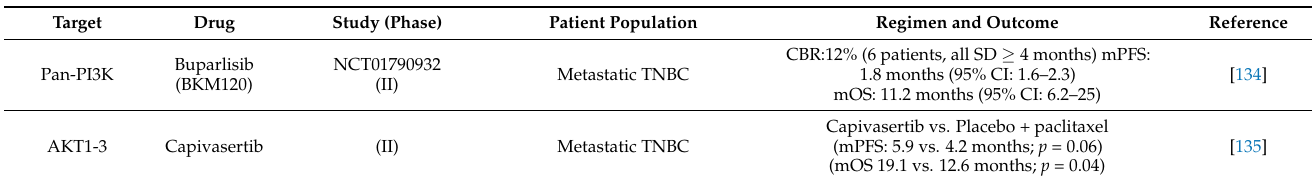
Table 5. Clinical trials of PAM inhibitors in triple negative breast cancer